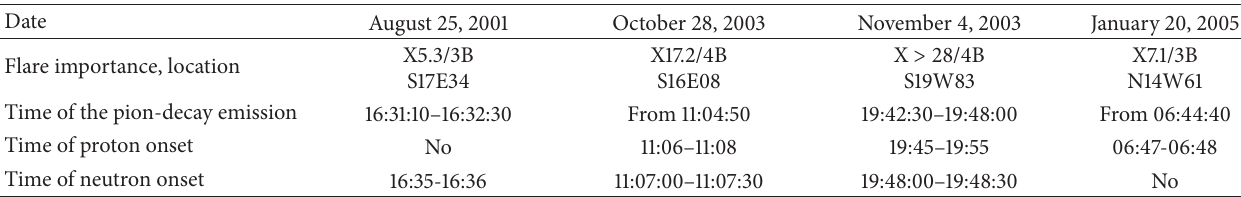
Figure 12: GLE 69, January 20, 2005. Left part, upper panel: SONG gamma-rays (black curve) and the soft X-ray derivative (red curve). The second panel: the count rates of three NMs obtained by the method of superposed epoch. Three panels below: Oulu, Apatity, and Norilsk NMs. The bottom panel: NM South Pole. Right: zoom of photon emissions and of count rates of 3NMs and NM South Pole. Table 1: Timing of pion-decay gamma emission and high-energy particle